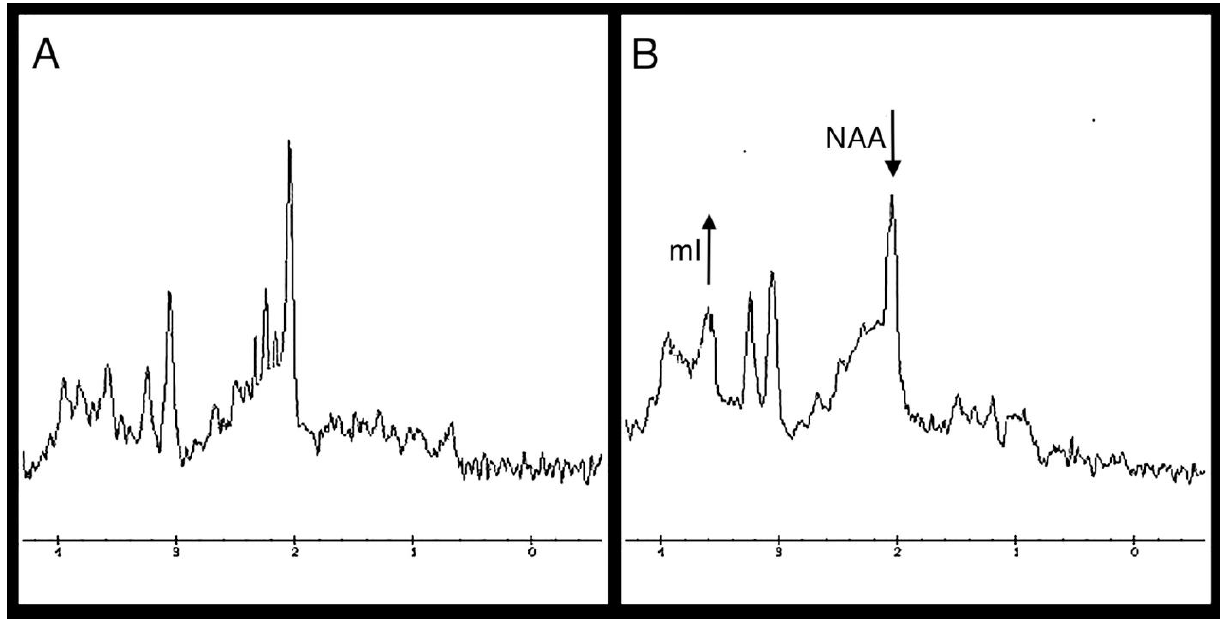
Figure 1. Exemplary 1 HMRS spectra obtained from volumes of interest in the brains of ( A ) a healthy control and ( B ) a soldier.